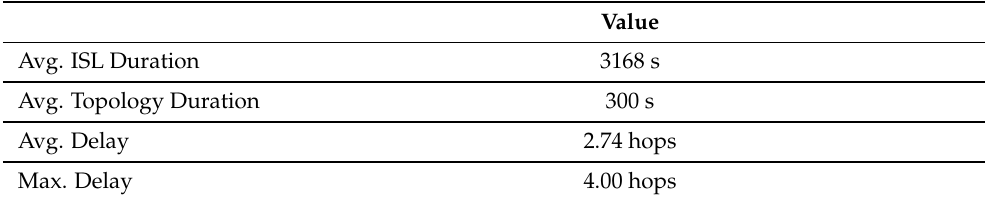
Figure 7. Topology snapshots of the link-building planning with LPTSO. Table 3. Performance of link-building planning with